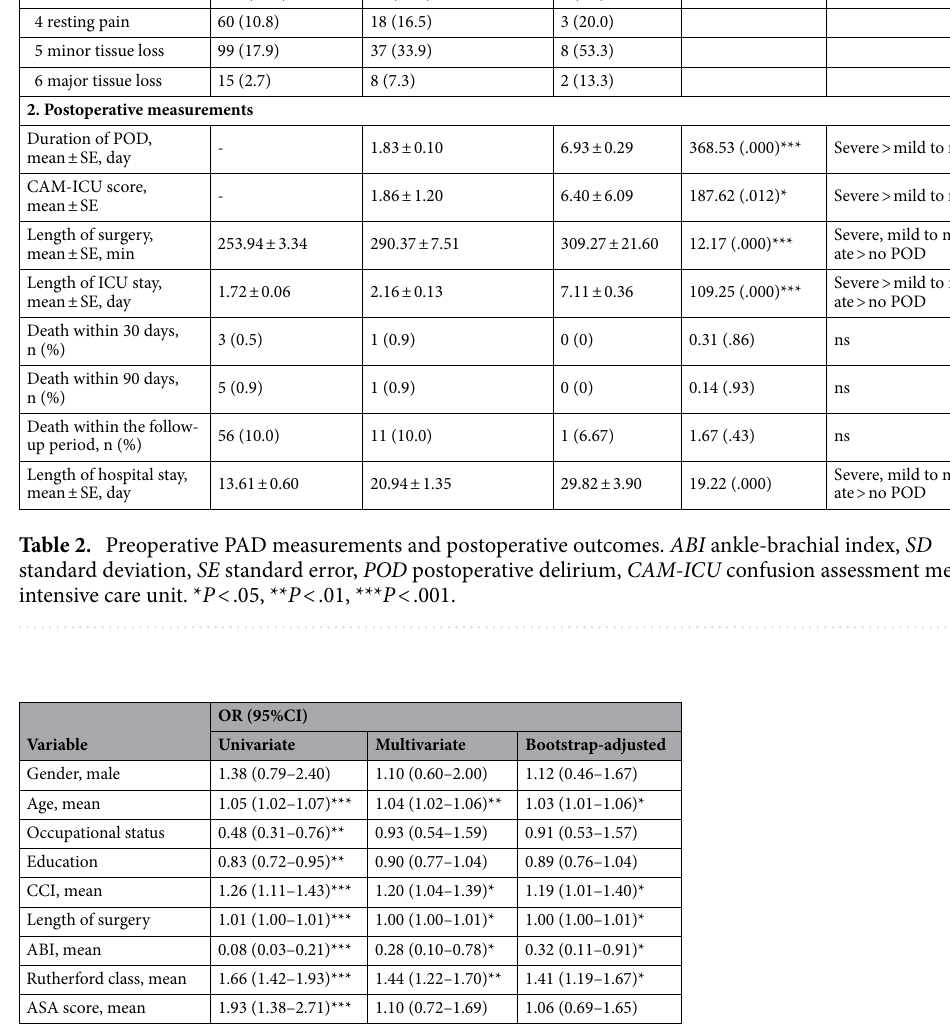
Table 3. Univariate, multivariate and bootstrap-adjusted analyses of the variables associated with POD. OR odds ratio, CI confidence interval, CCI Charlson comorbid index, ABI ankle-brachial index, ASA American anesthesiologist association. * P < .05, ** P < .01, *** P <